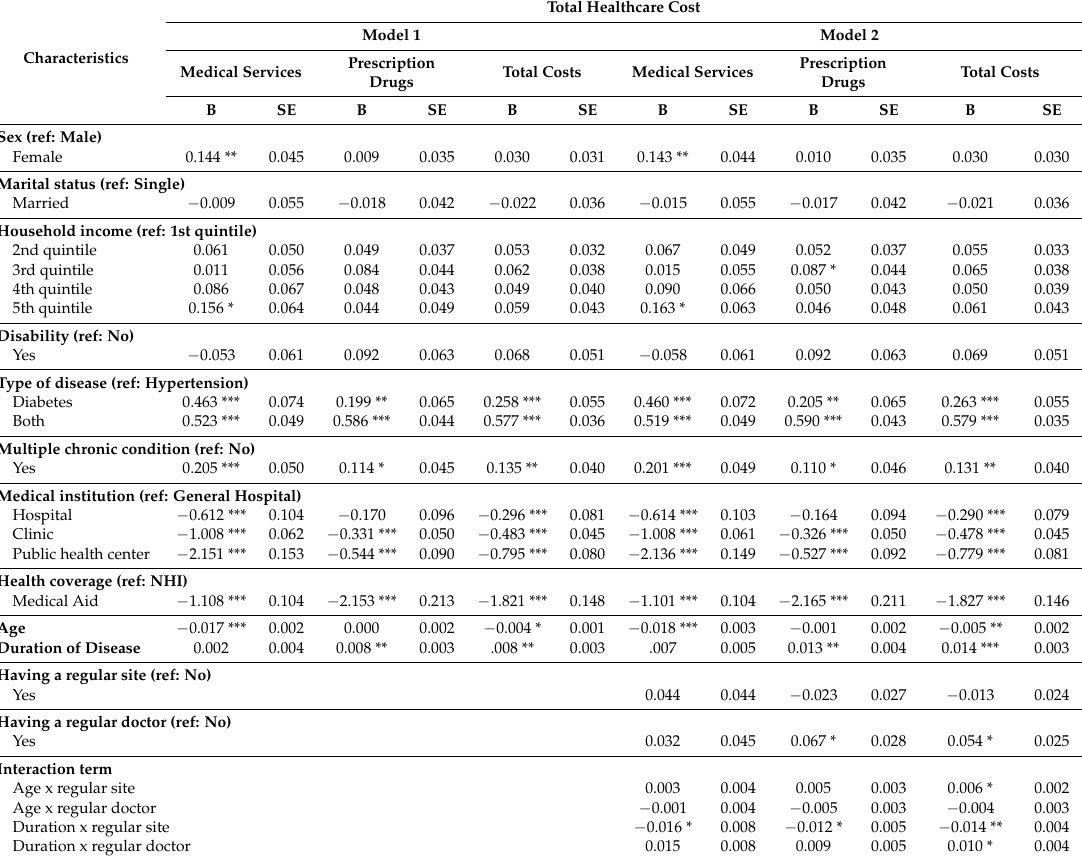
Table 4. The results of generalized estimation equation (GEE) analysis for CDM